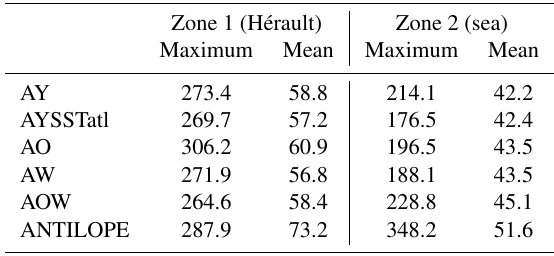
Table 4. Simulated maximum and mean values of rainfall amounts ( mm ) in 24h at 00:00UTC on 14 October over the Hérault zone and the offshore zone around MCSs for the different experiments (forecast starting at 00:00UTC on 13